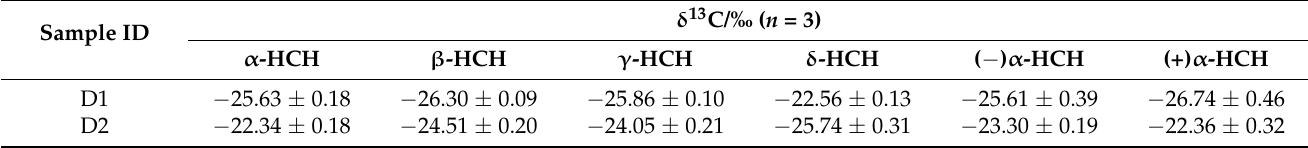
Table 4. The δ 13 C of HCHs of groundwater from contaminated